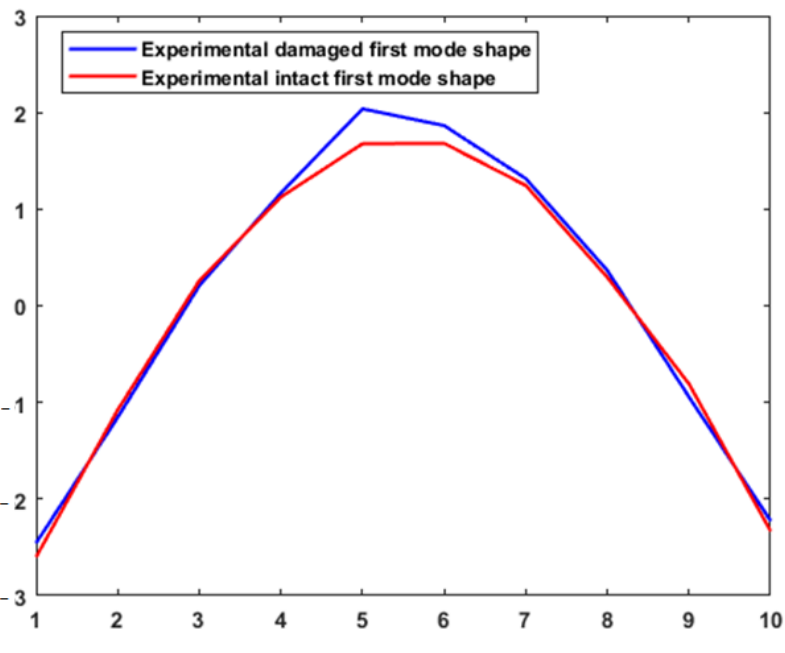
Figure 17. Experimental damaged and intact first mode shapes.